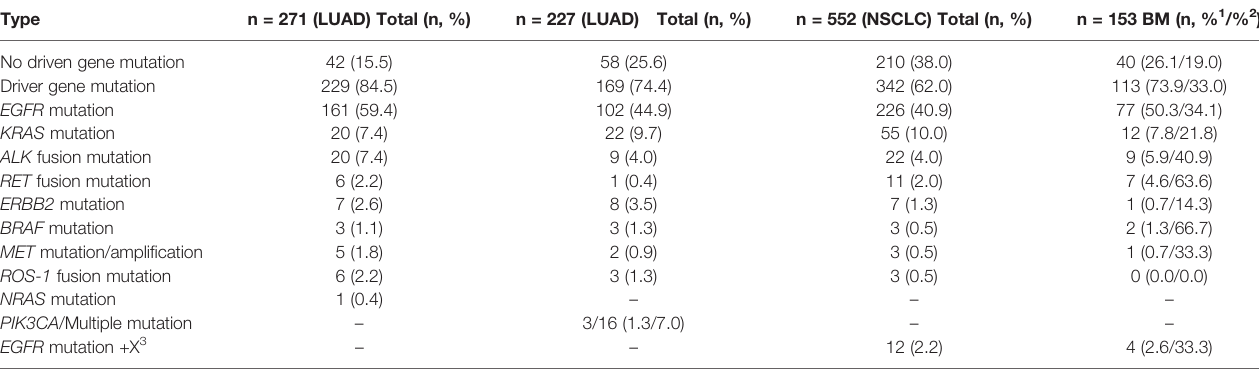
TABLE 1 | The distribution of the main driver gene mutation types of patients with lung cancer.